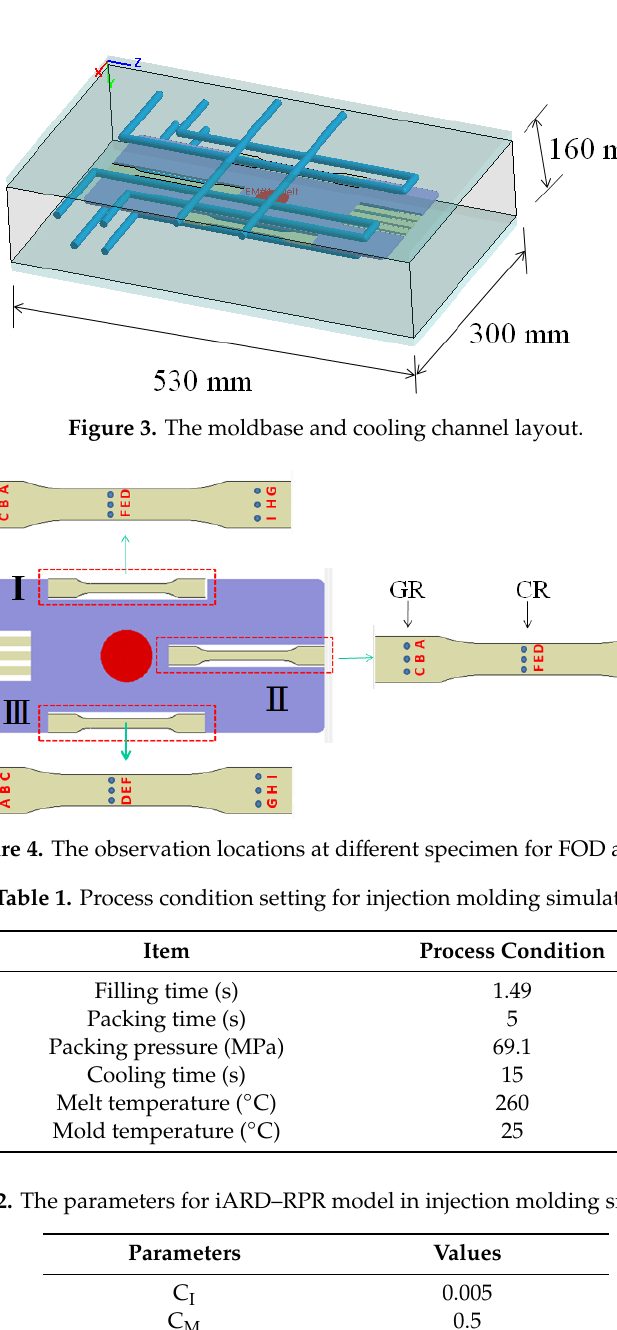
Figure 2. ( a ) The geometrical structure with three ASTM D638 specimens of different gate designs; ( b ) the dimension of the full sample.